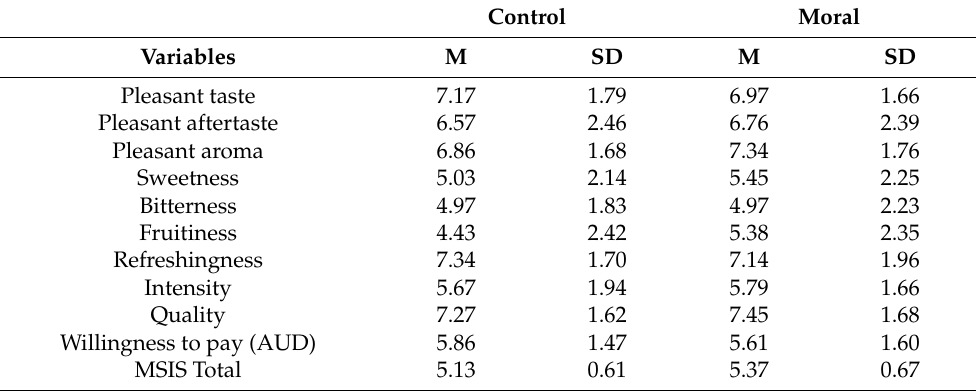
Table 3. Descriptive statistics for beer flavour characteristics for control and moral groups.